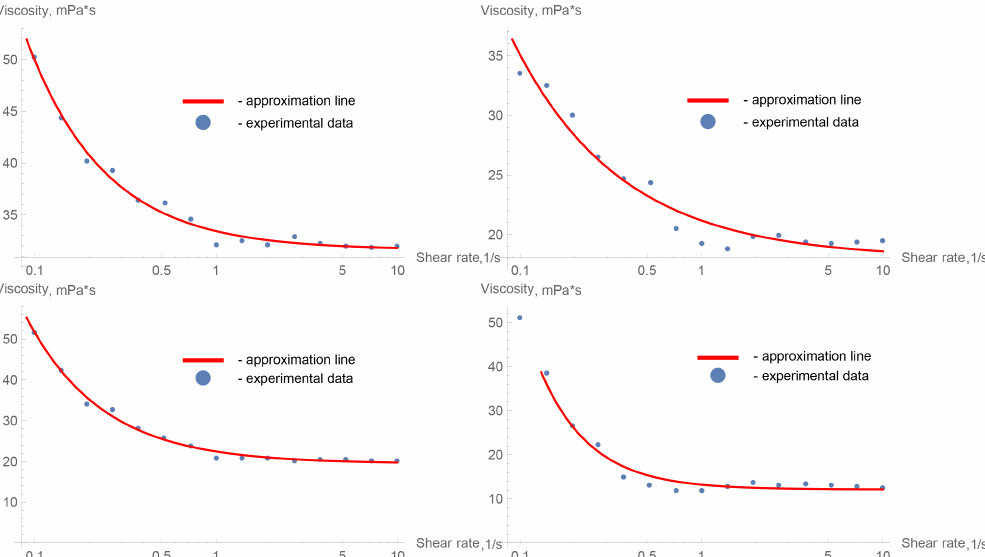
Figure 14. Approximation of experimental data of viscosity dependence on shear rate by Cisco’s (cid:114) (cid:114) model (CM) for the Onyx-18 embolic polymer ( top ) and the Squid-12 embolic polymer ( bottom ); for laboratory temperature T = 20 ◦ C ( left ) and for physiological conditions T = 37 ◦ C ( right ).